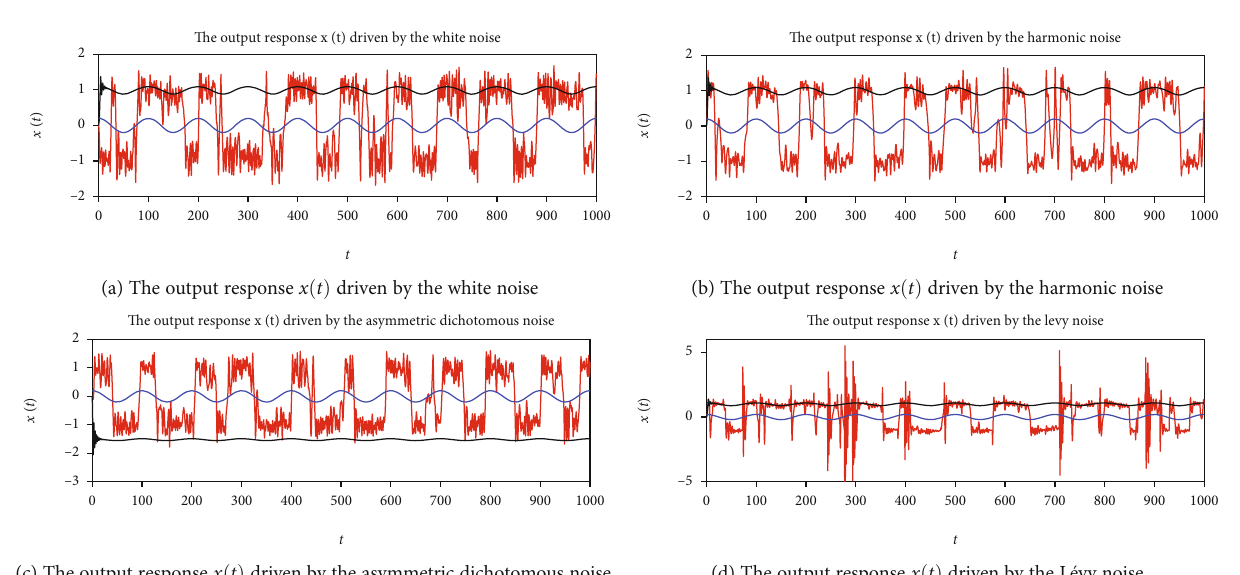
Figure 3: The system responses x ð t Þ for underdamped system under di ff erent noises. The values of the parameters for the numerical simulation are shown in Table 1. The blue line is for input sine signal. The black line is for D = 0 , and red line is for D = 0 : 07